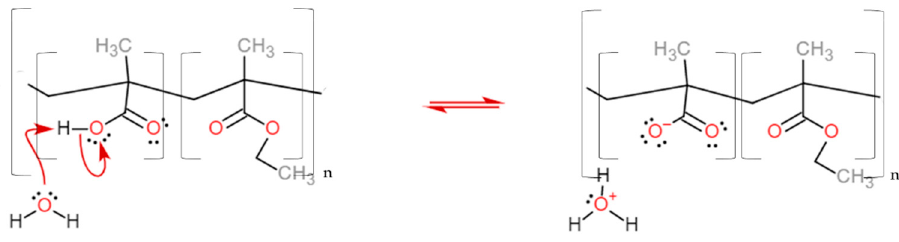
Figure 3. The reaction of the carboxylic acid monomer of the EUDRAGIT ® L 30 D-55 polymer with water leads to the polymer dissolution. The same reaction occurs for EUDRAGIT ® FS 30 D.